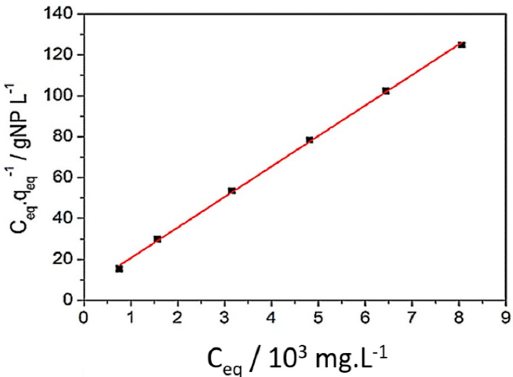
Figure 12. Linear plot of the adsorption isotherm of NP@-DTPA in Dy 3+ solutions, as expressed by the Langmuir equation.